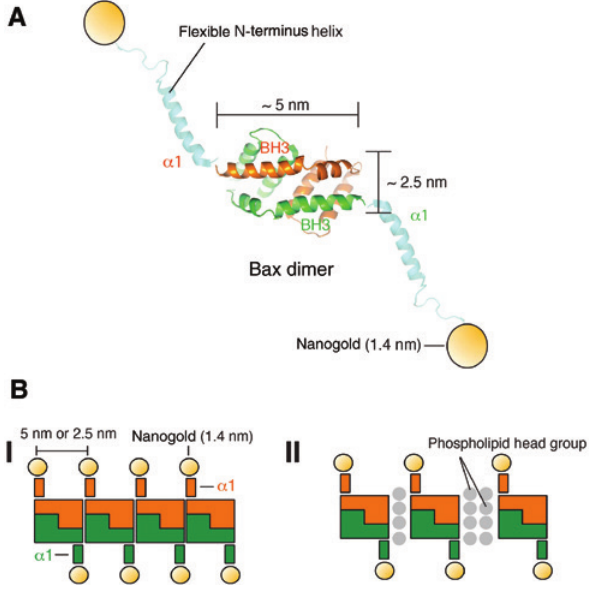
Figure 4: Model for Bax lining on the pore edges. (A) Schematic diagram of Bax symmetric dimer with conjugated nanogold. Nano- gold is attached at the tip of the flexible N-terminus helix ( α 1) not to disturb its native conformation. The BH3 domain from two Bax molecules (distinguished in green and orange) bind to each other’s pocket (BH3:groove) to form a symmetric dimer. The domain- swapped dimer in the core region is taken from the structure study by Czabotar et al. [45], and the diagram was drawn with the help of Dirk Zajonc (La Jolla Institute for Allergy and Immunology). The estimated length of the dimer core is 2.5 × 5 nm. The position and helicity of the N-terminus is pure speculation, and it only reflects the reported data that it is not part of the core dimer [46, 64]. (B) Two hypothetical ways to align Bax higher-order oligomers in the pore edges. (I) Two molecules of domain-swapped dimer of Bax (orange and green) line without lipids in between. In this case, the inter-particle distance would be 5 or 2.5 nm depending on the dimer orientation (see A). If all conjugated Bax molecules participated in pore formation, we would expect to see two lines of gold particles with 5- or 2.5-nm interval. Our labeling was ~ 80% at best, and nanogold-labeled Bax was less active than the wild type; therefore, we suspect that non-labeled species may preferentially participate in pore formation. (II) Lipids come in between the dimers to form lipidic pore. The inter-particle distance would be larger than (I). These models are based on the assumption that the gold particles are located on the tips of the α 1 helix and that the N-terminus is flexible. It remains to be seen whether these assumptions are